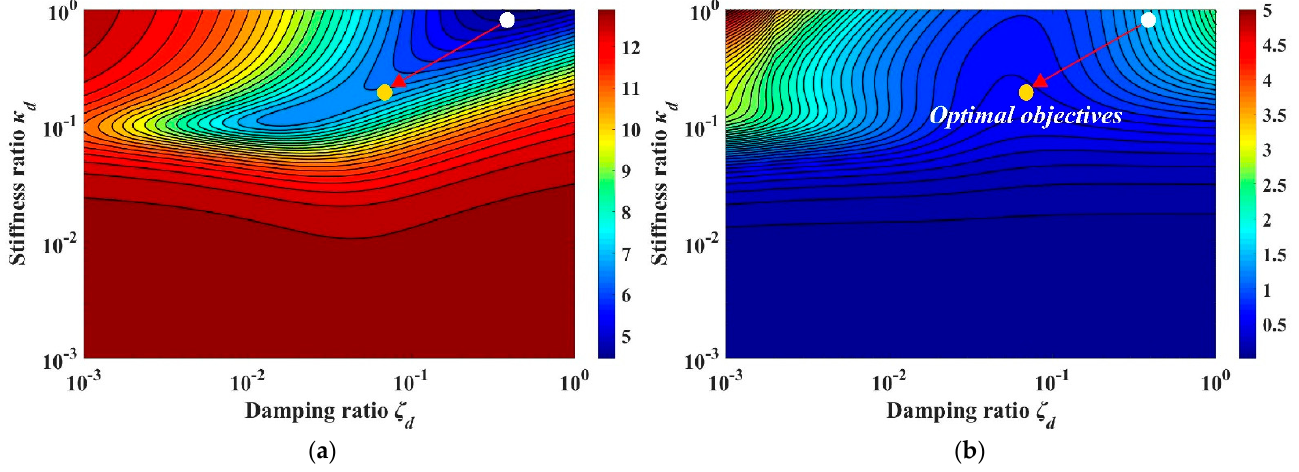
Figure 14. 2D Contour plot of σ Ue and σ Fd of SC system ( μ d = 0.1): ( a ) σ Ue ; and ( b ) σ Fd .